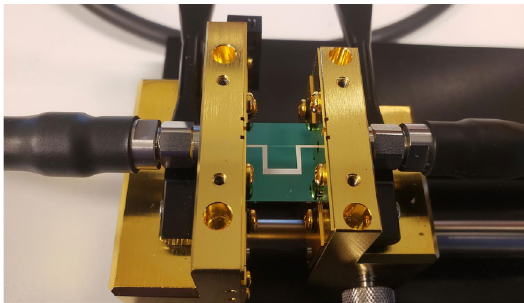
Figure 12. Photograph of the device under test.